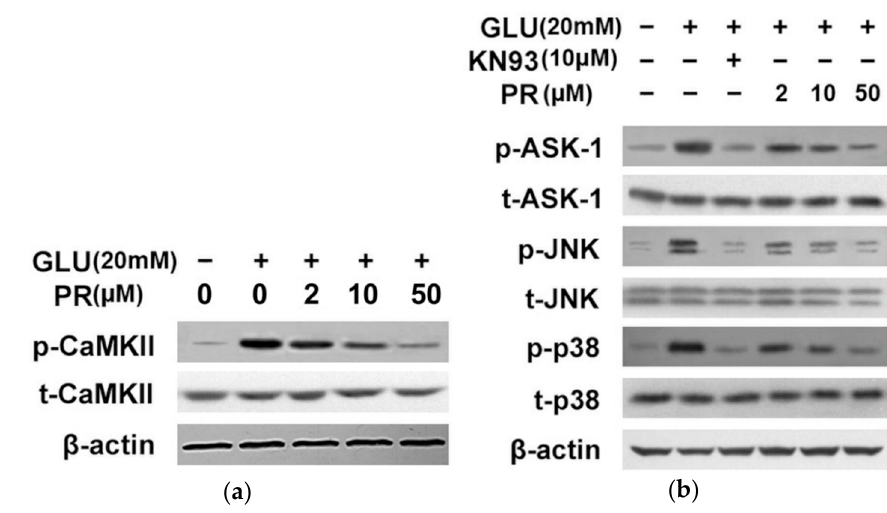
Figure 6. Cont. Figure 6. Puerarin attenuated the glutamate-induced activation of calmodulin-dependent protein kinase II (CaMKII)-dependent apoptosis signal-regulating kinase 1(ASK-1)/c-Jun N-terminal kinase (JNK)/p38 signaling pathway. Cells were pre-treated with puerarin (0, 2, 10 and 50 μ M) for 24 h and then exposed to 20 mM glutamate for 24 h. ( a , b ) The expression levels of relative proteins were determined by western blot analysis using indicated antibodies. All data were representative of three independent experiments. The internal control was β -actin.